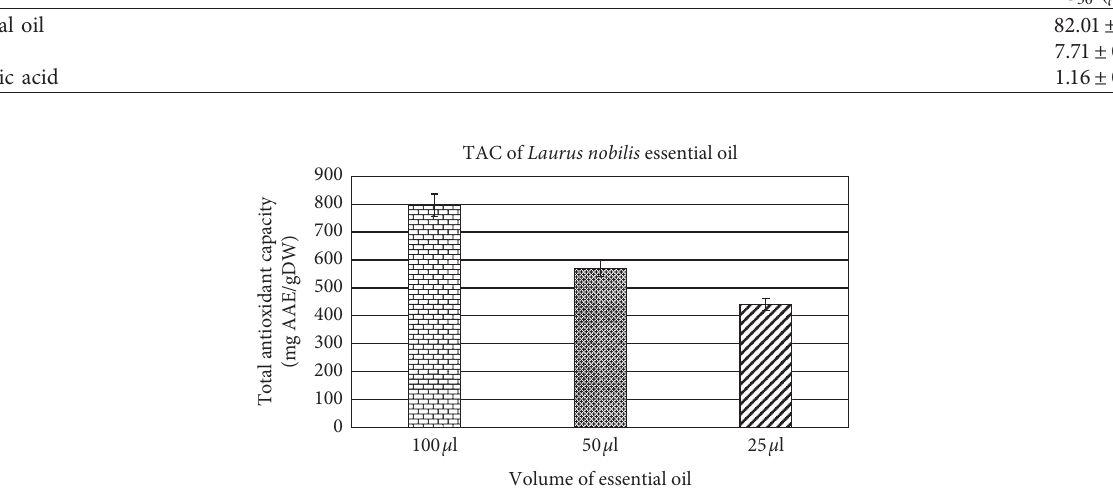
Figure 2: Total antioxidant capacity of different volumes of essential oil from L. nobilis flowers. Results are expressed as mg